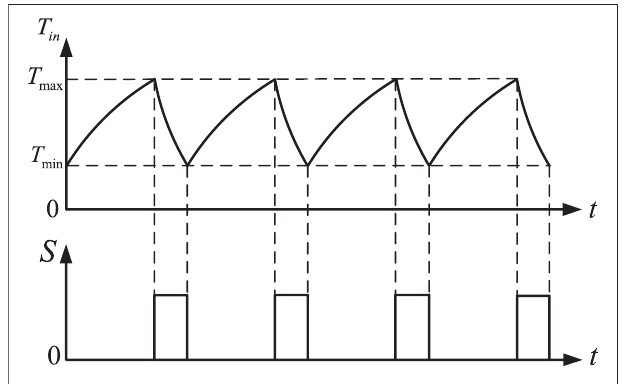
FIGURE 2 | Working characteristics of the fi xed-frequency air conditioning compressor.